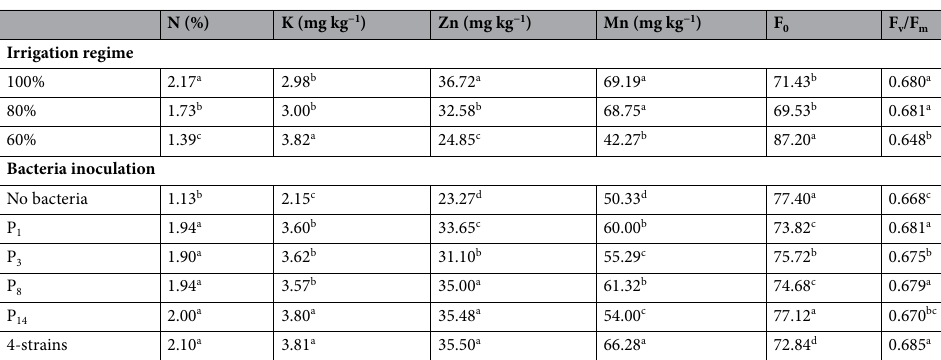
Table 5. Mean comparisons of main effects irrigation regime and bacteria inoculation on chlorophyll fluorescence parameters and nutrients content of sweet corn leaf. P 1 , P 3 , P 8 , P 14 : four strains of P. fluorescens , 4 strains: combination of four strains. The same letters on each comparison have no significant different (LSD at p ≤ 0.05). Fv indicates variable fluorescence; Fm indicates maximum fluorescence.